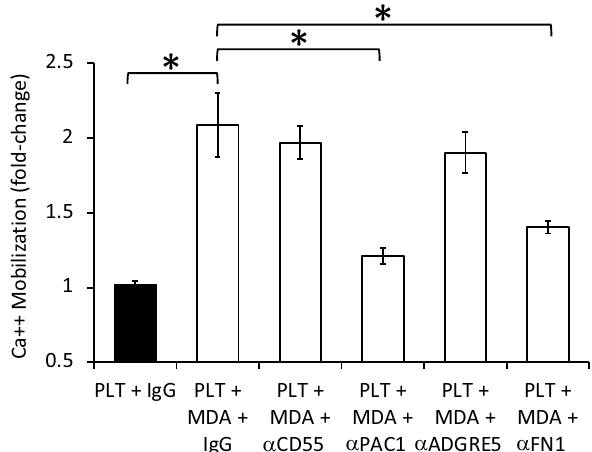
Figure 5. α IIb β 3 -FN1 signaling axis mediates PCa cell-stimulated calcium mobilization in PLTs. MDA PCa 2b (MDA)-stimulated calcium mobilization in platelets (PLT) was examined in the presence of IgG isotype control (5 µg/ml) or indicated blocking antibody (α; 5 µg/ml). Cell:PLT ratio was 1:1000. Data presented as the mean ± SEM of n = 6–9 independent determinations and analyzed by ANOVA and Tukey post-hoc test, * P <